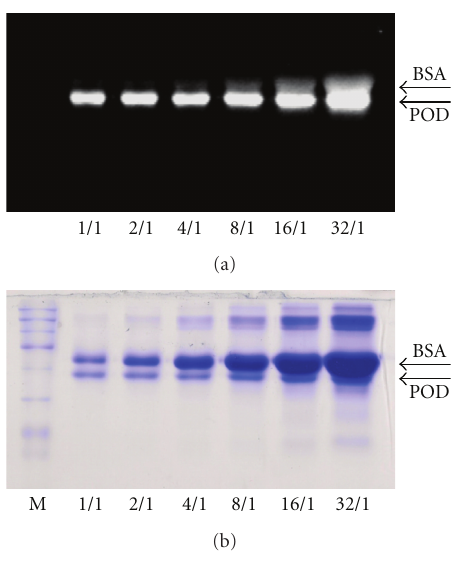
Figure 1: Detection of LRSH-labeled α 1-acid glycoproteins in SDS-polyacrylamide gel with di ff erent imagers and poststaining with Coomassie blue. Twofold serial dilutions of the glycoproteins, ranging from 1 μ g to 0.95 ng, are displayed in Lane 1 to Lane 11. M denotes molecular weight markers. (a) UV 305-nm excitation and CCD camera detection in a UV transilluminator. (b) 532- nm excitation and detection in a Typhoon 9210 laser scanner. (c) Poststaining of the same gel with Coomassie blue.